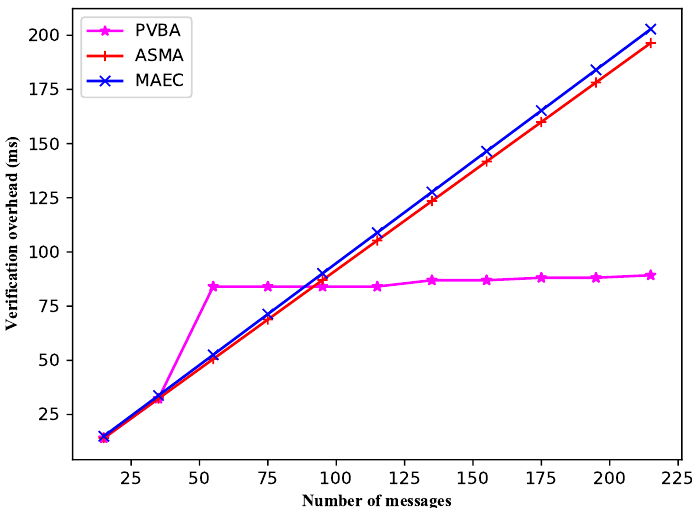
Figure 4. The computation overhead comparison for different schemes.